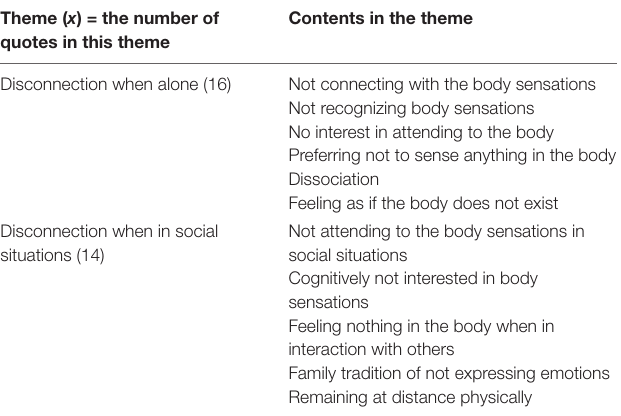
TABLE 3 | Latent profile analysis results: two profiles.